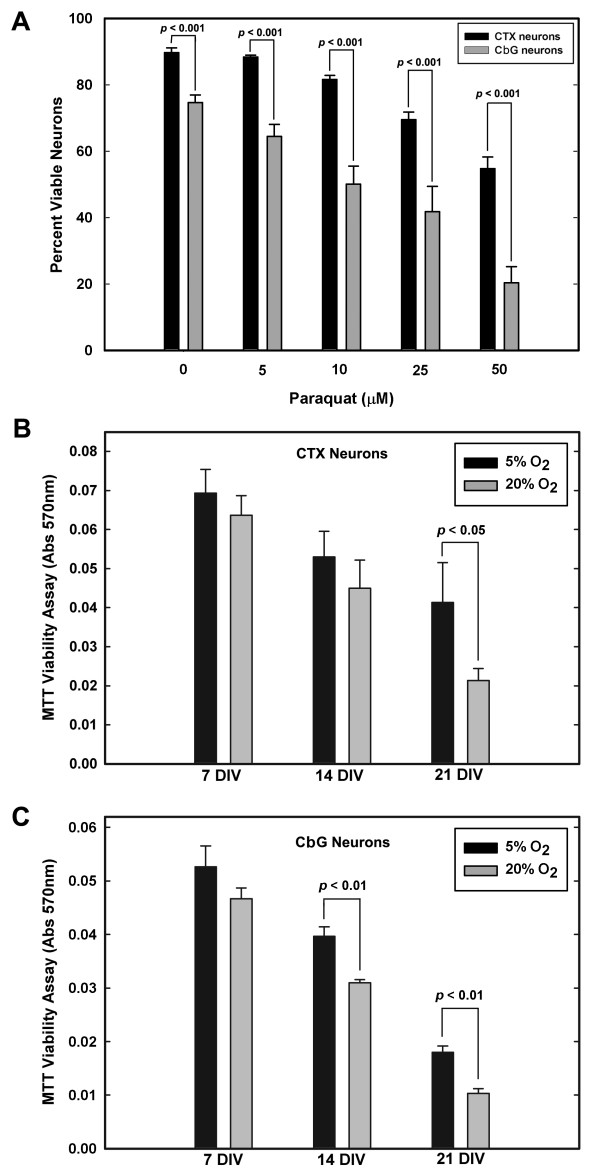
Effect of paraquat and of differential levels of oxygen tension on the viability of primary CbG and cerebral cortical (CTX) neurons. (A) Effects of paraquat on neuronal viability. Both types of neurons were exposed to the indicated concentrations of paraquat for 24 h at 37°C. Cell viability was determined by the calcein AM and PI labeling method. Data represent the mean (± SEM) of neuronal viability from 10 experiments. The P values from Student's t-test are shown for the indicated comparisons. (B, C) Survival of neurons across days in vitro (DIV) under different levels of oxygen (5% and 20%). Viability of neurons was measured by the MTT assay. The data represent the mean (± SEM) from 3 experiments. Statistically significant differences (t-test) are shown for the indicated comparisons.